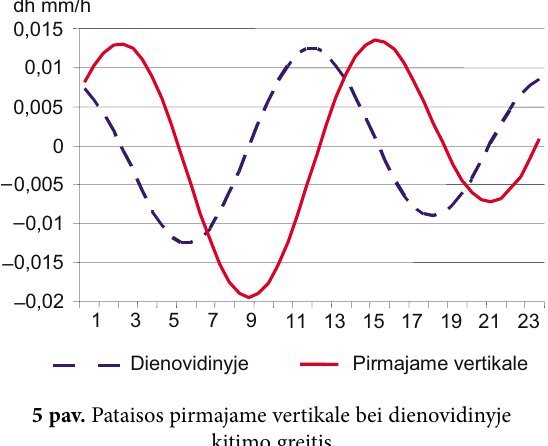
Fig. 5. Rate of change of lunisolar correction in prime vertical and